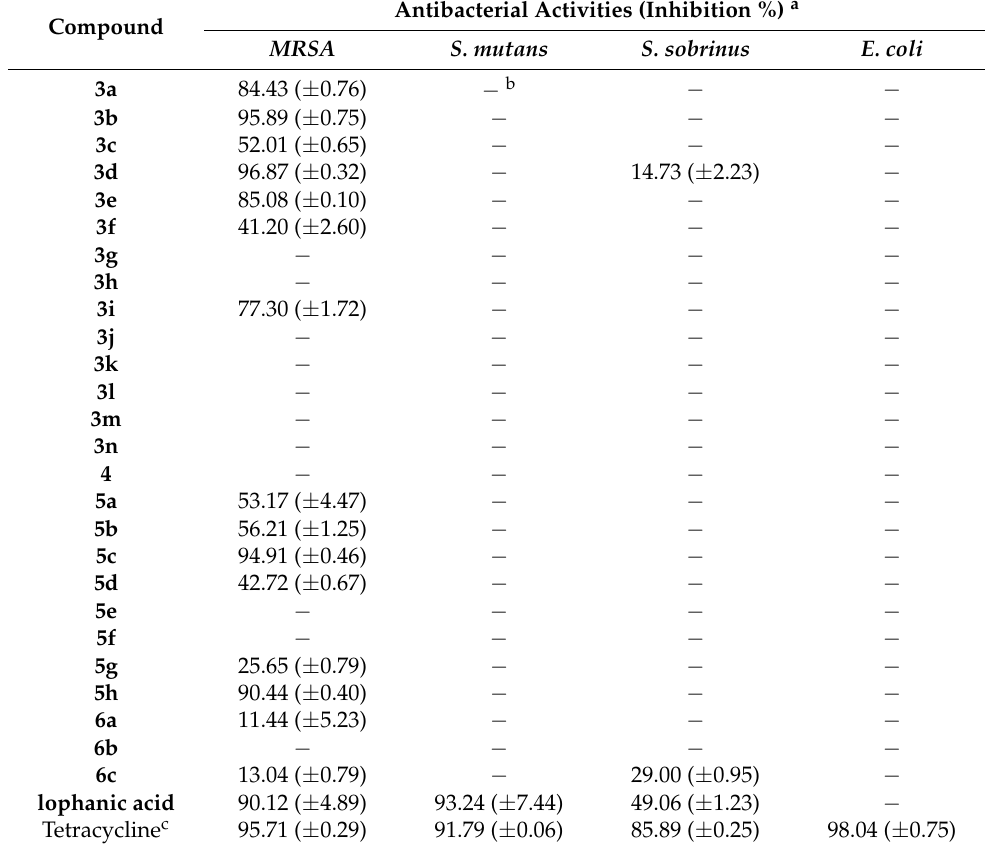
Table 2. Antibacterial activities of compounds 3a – 6c at 100 µ g/mL.